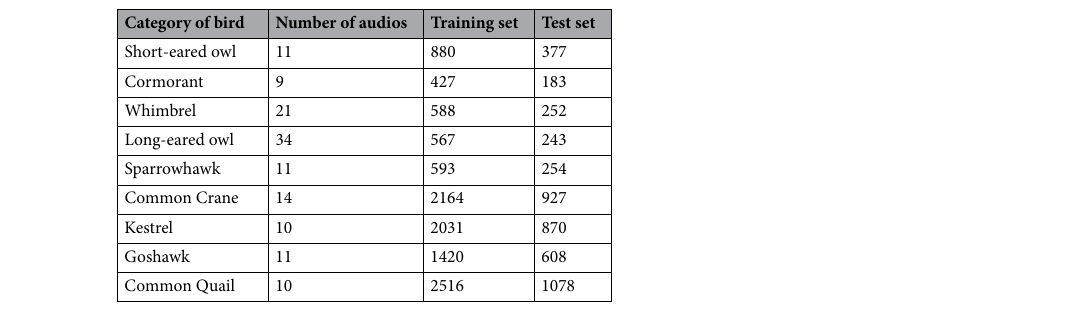
Table 2. Datasets of birdsongs